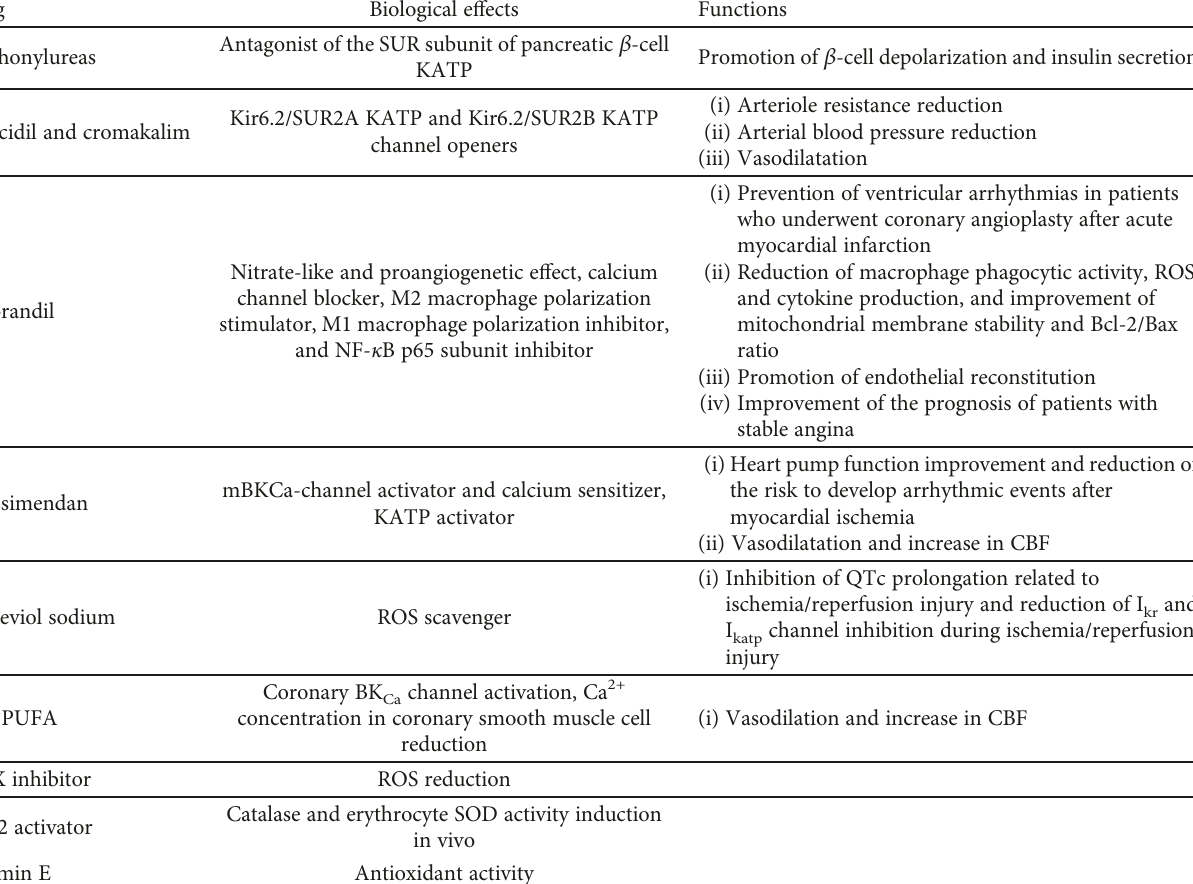
Table 2: Main drugs and molecules which may have a role against IHD using ion channels as therapeutic target.